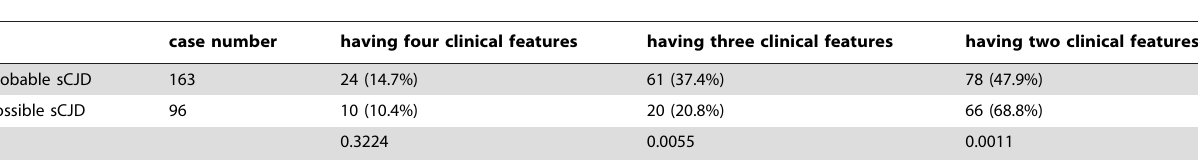
Table 3. The frequencies of other four clinical manifestations except progressive dementia in probable and possible sCJD patients.